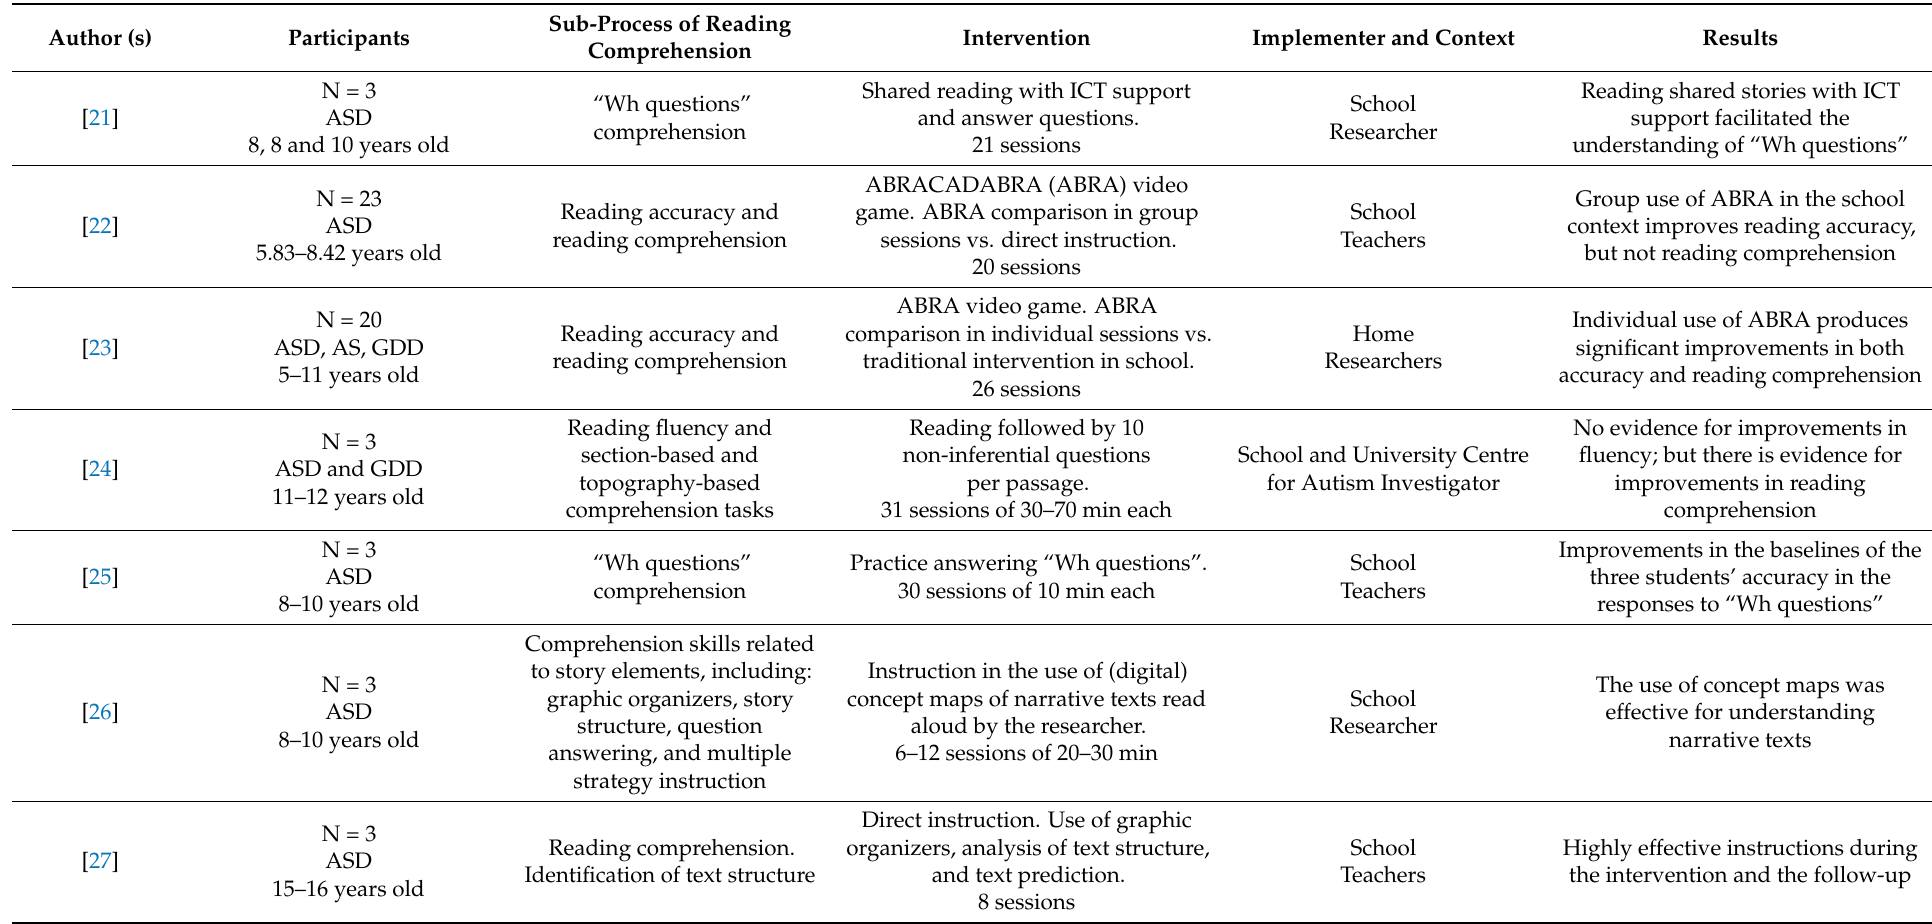
Table 1. Analysis of the studies included in the